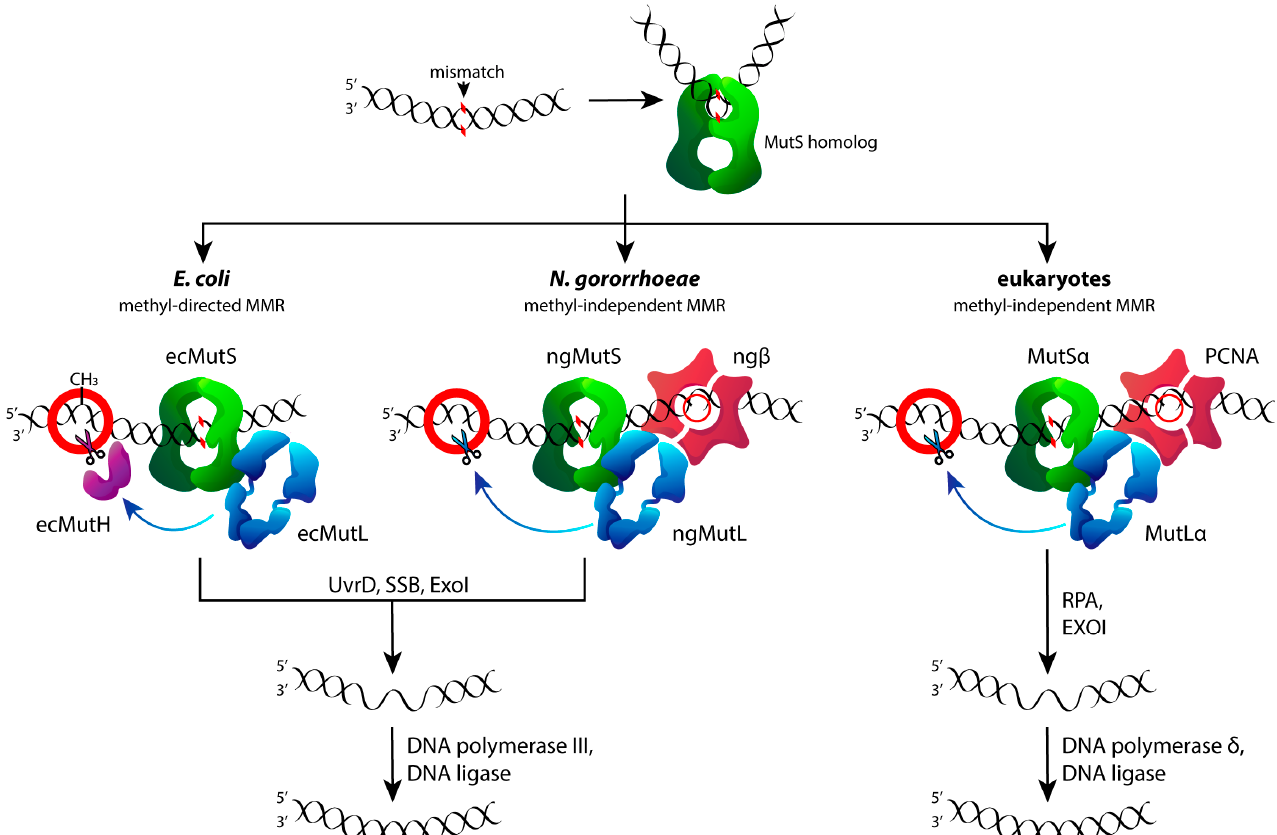
Figure 2. Mechanisms of the mismatch repair process in E. coli ( left ), Neisseria gonorrhoeae ( center ), and eukaryotes ( right ). In bacteria, homodimeric MutS recognizes mismatches and forms a complex at the site of the DNA mismatch. MutS then recruits MutL into the complex in an ATP-dependent manner. Similarly, in eukaryotes, heterodimeric MutS α is responsible for mismatch recognition and MutL α recruitment. In γ‐ proteobacteria (including E. coli ), the MutS–MutL complex activates the MutH endonuclease, which nicks the unmethylated DNA strand (methyl ‐ directed MMR). Most prokaryotes and all eukaryotes lack the MutH gene. In these organisms, MutL homologs (MutL homodimer for bacteria and MutL α heterodimer for eukaryotes) have endonuclease activity and selectively cut the newly synthesized strand (methyl ‐ independent MMR). In this case, pre ‐ existing nicks are important to distinguish the daughter strand.